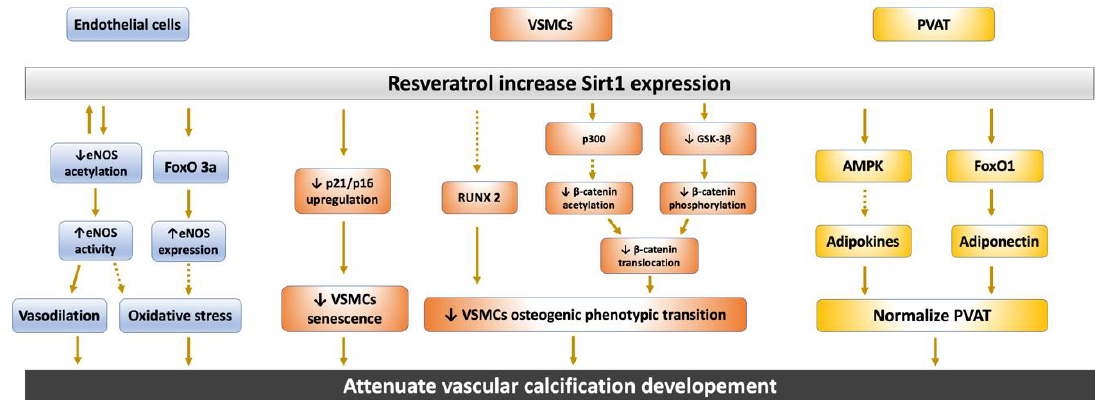
Figure 3. The protective role of Sirt1 activator resveratrol in attenuating vascular calcification. In epithelial cells, Sirt1 and eNOS / NO can regulate each other in a positive feedback loop to possess significant antioxidant and anti-inflammatory properties. Sirt1 inhibit the upregulation of the p16 and p21 expression and thereby delay cell VSMCs senescence. Additionally, Sirt1 directly inhibit osteogenic phenotypic transdi ff erentiation of VSMCs through deacetylation of RUNX2 and β -catenin. Sirt1 protects against oxidative stress and inflammatory insult by preventing adipocytokine release through the AMPK pathway or normalizing adiponectin secretion in PVAT. AMPK, adenosine monophosphate-activated protein kinase; FoxO, Forkhead box O; GSK-3 β , glycogen synthase kinase-3 beta; NO, nitric oxide; NOS, NO synthase; RUNX2, runt-related transcription factor-2; PVAT, perivascular adipose tissue; and VSMCs, vascular smooth muscle cells. (Solid arrow: promote; Dotted arrow: inhibit )